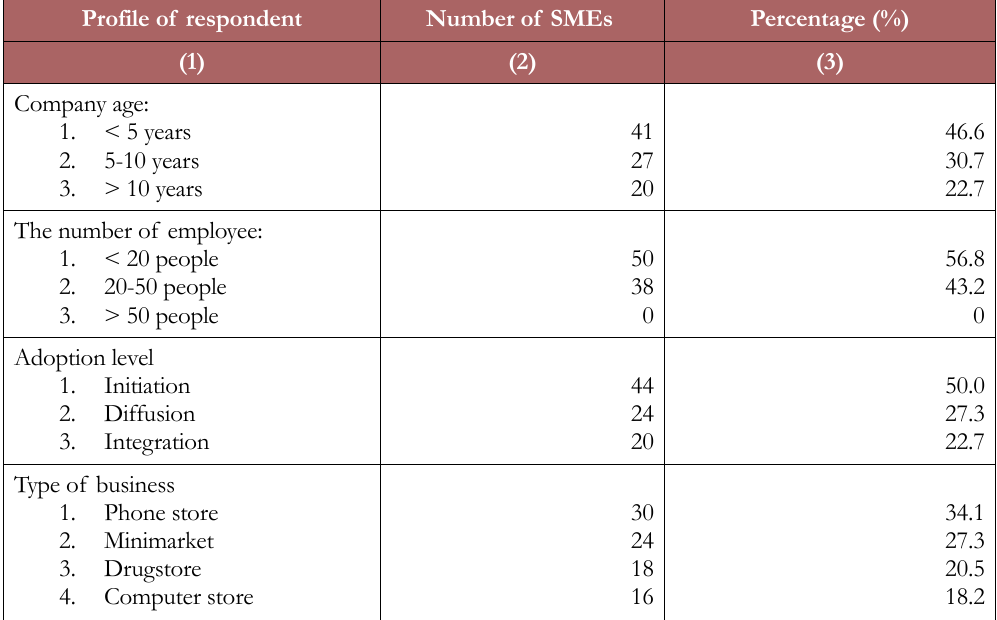
Table 2. Respondent